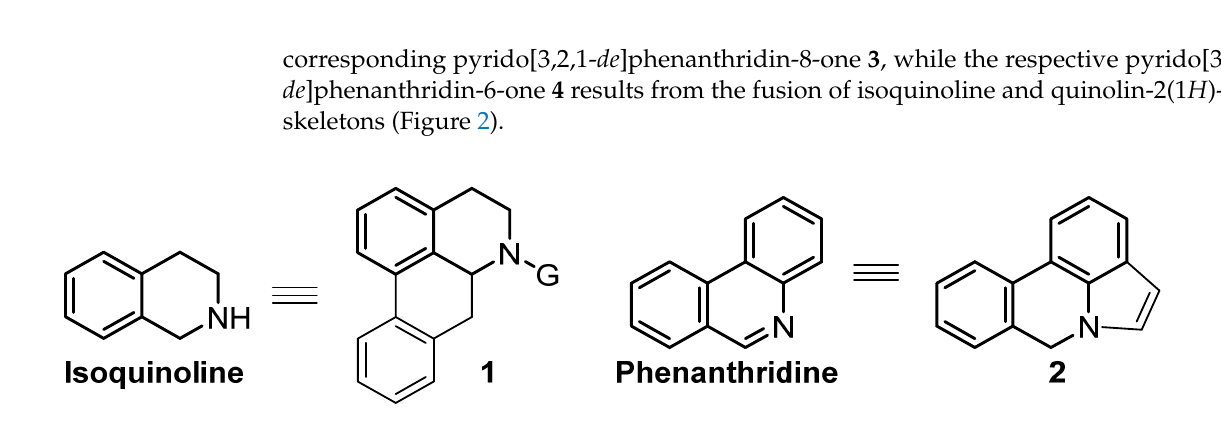
Molecules 2022 , 27 , x FOR PEER REVIEW